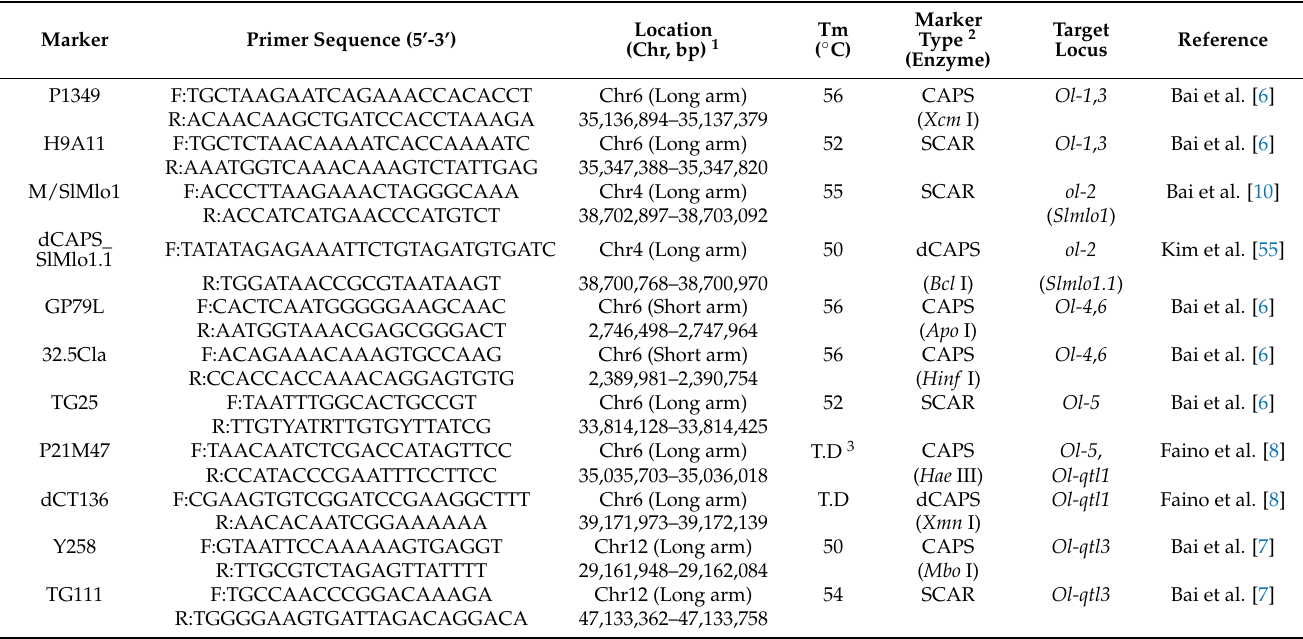
Table 5. List of DNA markers for powdery mildew resistance in tomato reported in previous studies. The markers used for the genotyping tomato germplasm were highly resistant or susceptible to Oidium neolycopersici